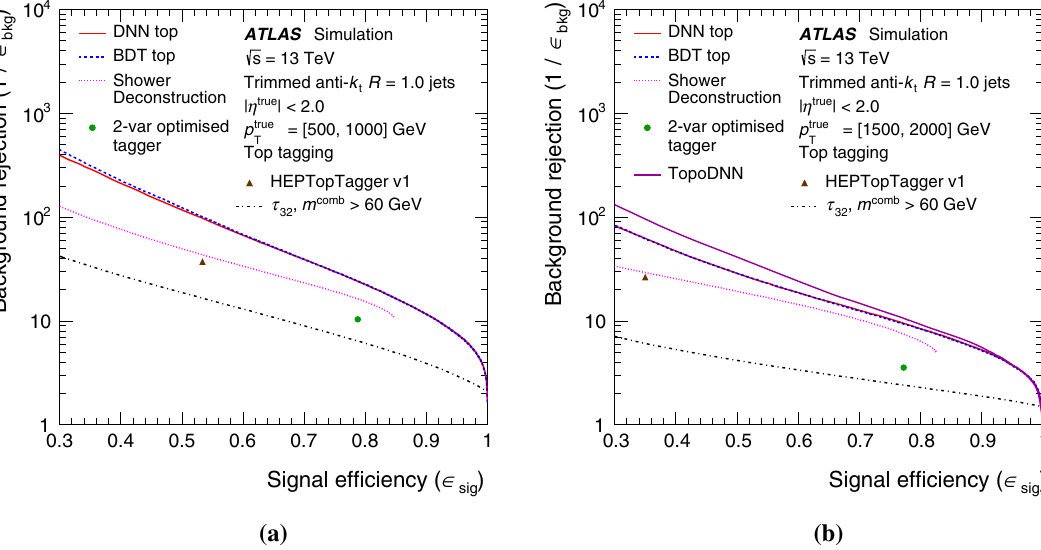
Fig. 8 The performance comparison of the top-quark taggers in a low- p true distribution of the signal jets weighted to match that of the dijet background